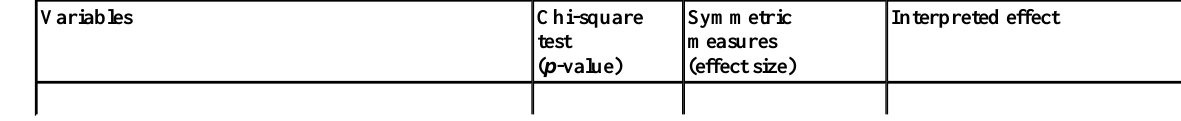
When comparing the socio-economic situations of alumni of the UJ with the variables listed in column 1 of Table 3, the effect of this factor on the access and use of ICTs could be established. The different categories given in Chart 6 have been grouped together to make a differentiation between alumni describing themselves as Poor to Average, and those alumni who fall under the categories of Above Average and Affluent. Table 3 Effect of socio-economic circumstances on ICT access and usage patterns of the alumni of the UJ